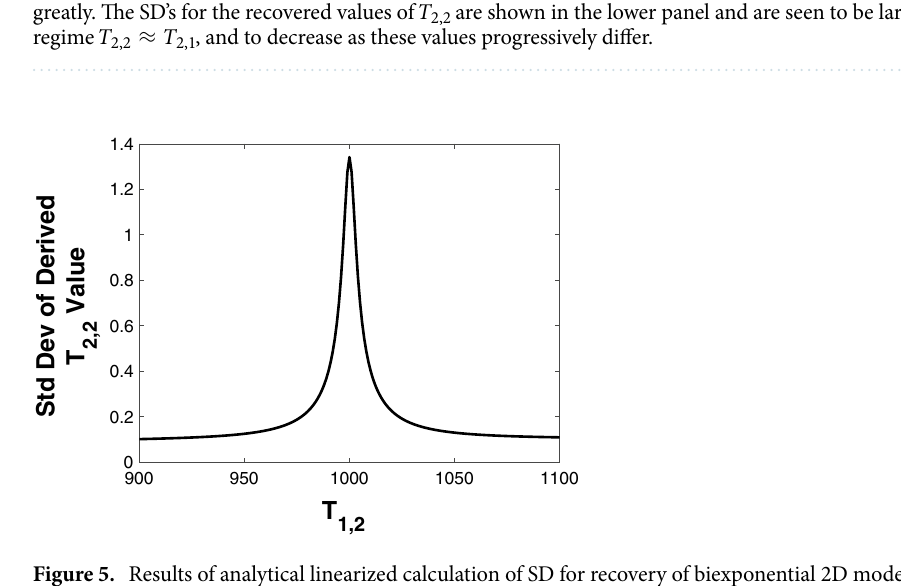
c c T ( 0.3, 0.7, 60 ms ) . 1 , 2 , 2,1 = (cid:31) (cid:30)